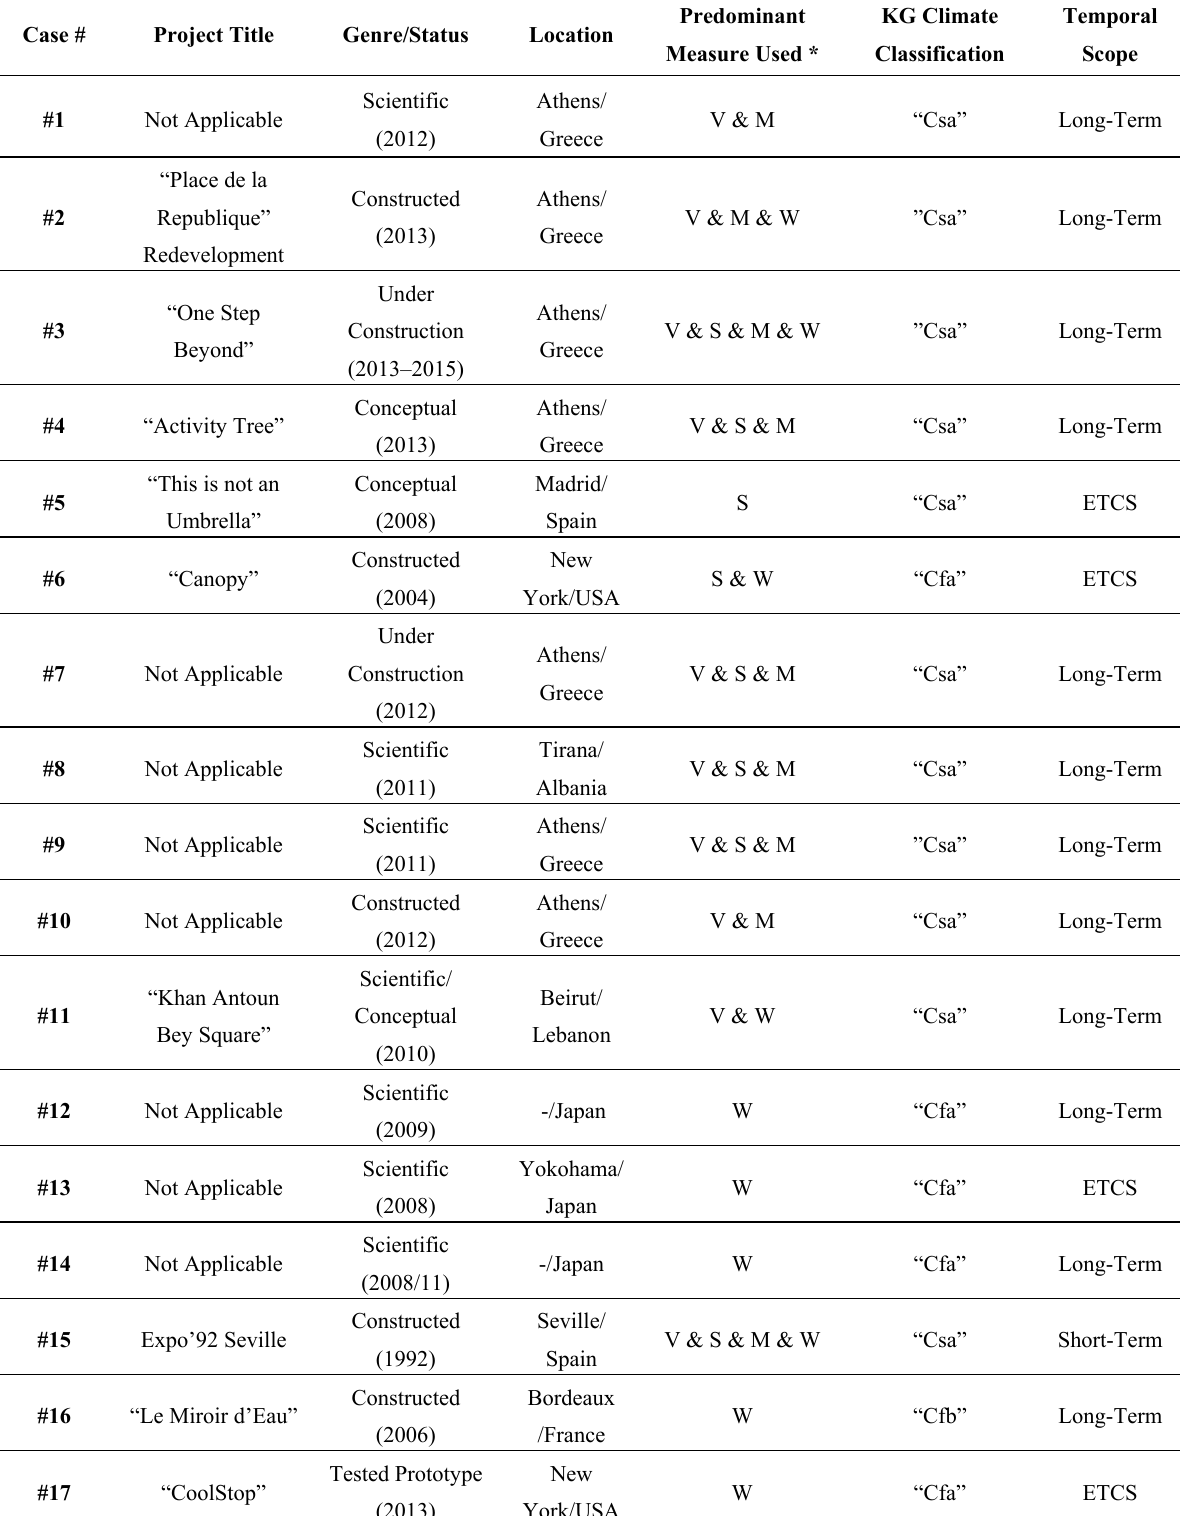
Table 4. Framework of relevant bioclimatic case studies within the international